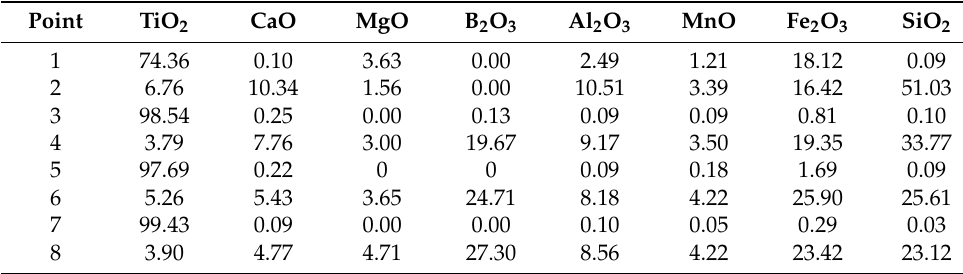
Table 1. The chemical composition of the points in Figure 2